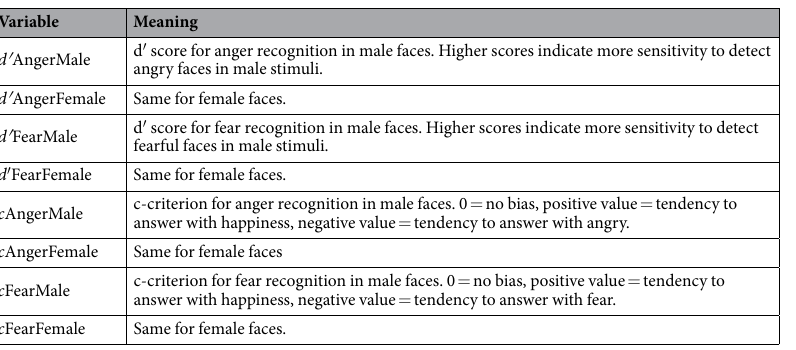
Table 1. Response variables from the signal detection analysis included in the Bayesian